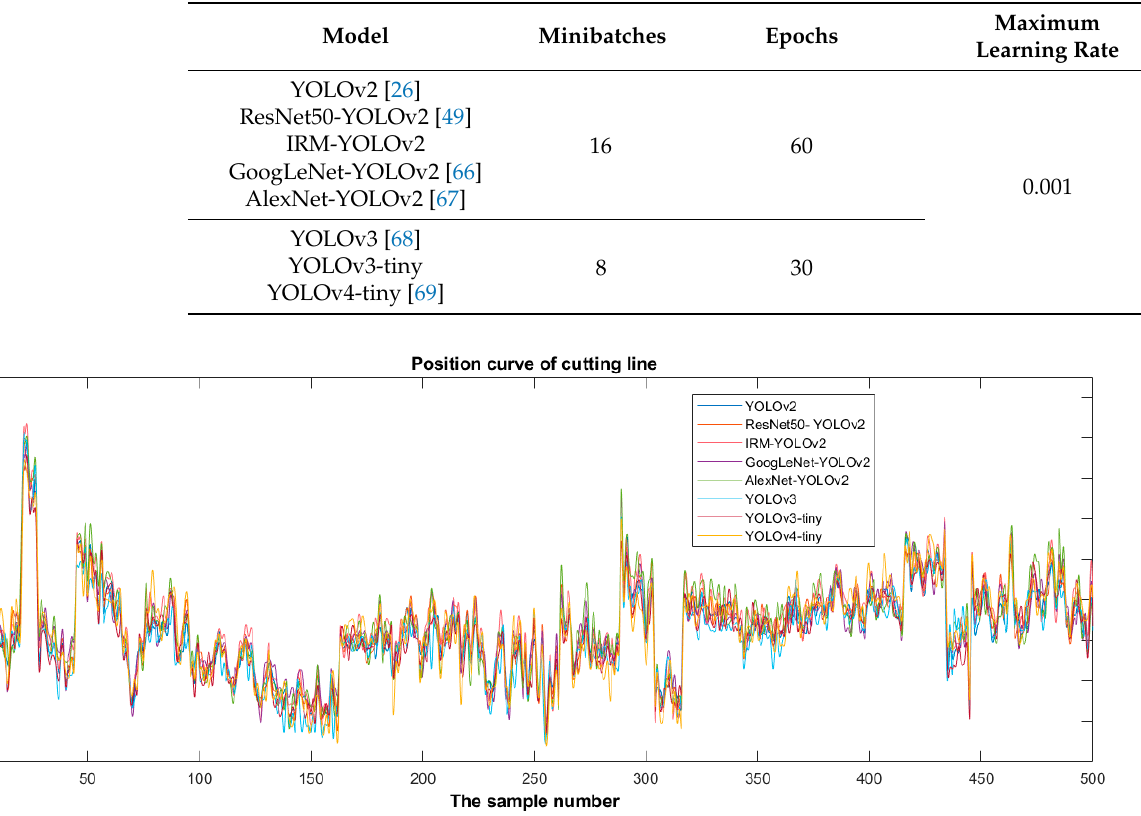
Figure 9. Distribution of detection results of different algorithms.